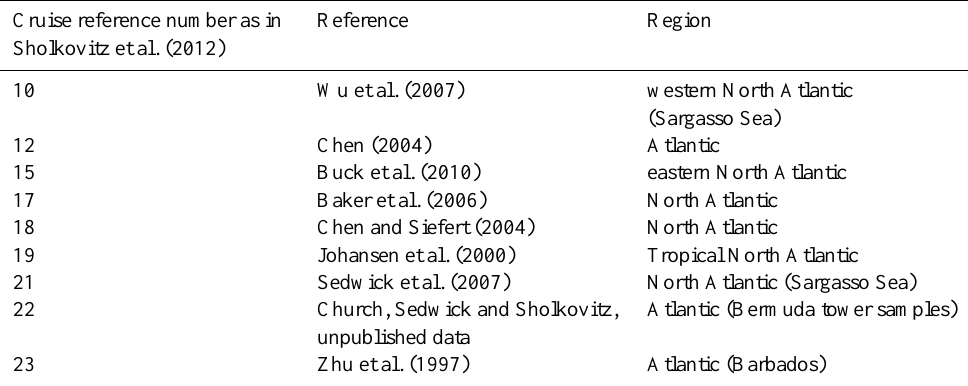
Table 4. Group G2 of cruises from which data have been used in this study. Cruise reference number as